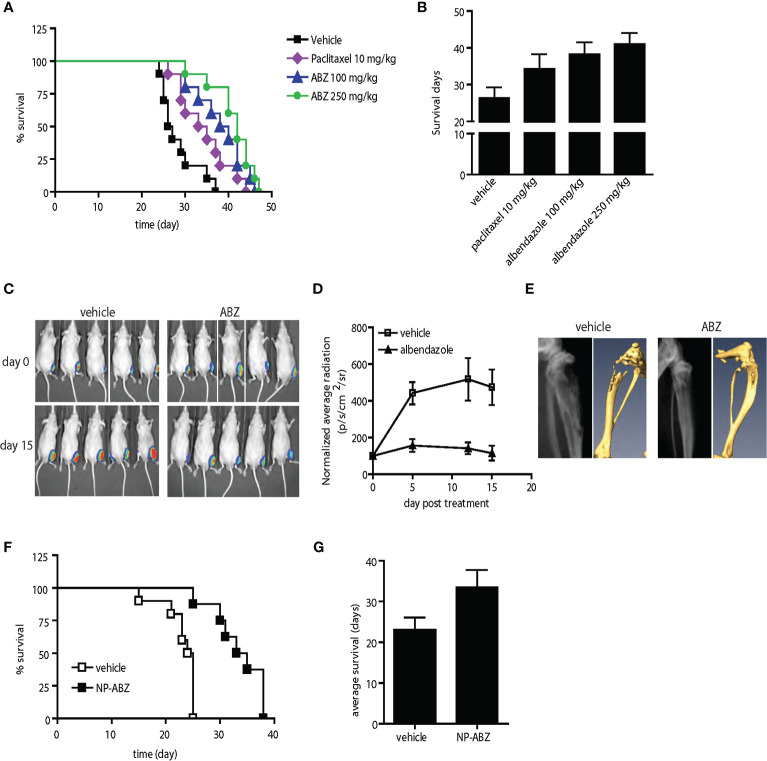
Anti-tumor activity of albendazole in comparison with paclitaxel and in experimental bone metastasis of prostate cancer in vivo. (A, B) AT6.1 cells were inoculated intravenously five days prior to treatment of either paclitaxel or albendazole (ABZ). Shown are Kaplan Meier survival curve (A) and the average survival days (B) for each treatment group; N=10 per group, p<0.001 in vehicle vs. paclitaxel, vehicle vs. ABZ 100mg/kg, vehicle vs. ABZ 250mg/kg and paclitaxel vs. ABZ 250mg/kg. (C–E) Bone lesions of PC-3MLN4 cells were generated by intraosseous injection into the tibia of mice, before treatment with vehicle or 100 mg/kg albendazole (ABZ), three times a week for two weeks. (C) Representative photos of luciferase signal detected in each treatment group at the beginning and end of study. (D) Mean of luciferase signals detected in mice during treatment, as a measurement of tumor burden. (E) Representative images from X-ray (left) and micro-CT (right) analysis showing differences in radiographical characteristics of the bone lesions. Data shown are mean ± 95% confidence interval, N=10 per group. (F, G) AT6.1 cells were inoculated intravenously five days prior to treatment of either vehicle or nanoparticle-albendazole (NP-ABZ). Shown are Kaplan Meier survival curve (F) and the average survival days (G) for each treatment group; N=10 per group, p < 0.001 in vehicle vs. NP-ABZ.